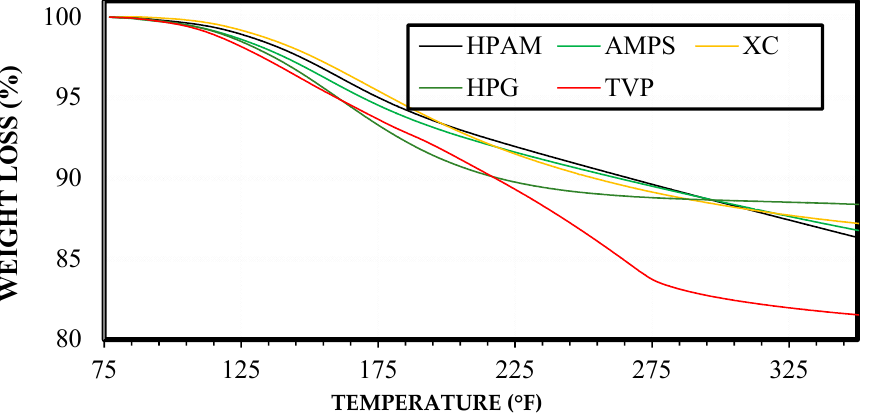
Figure 3. Thermogravimetric analysis of polymers used in this work.